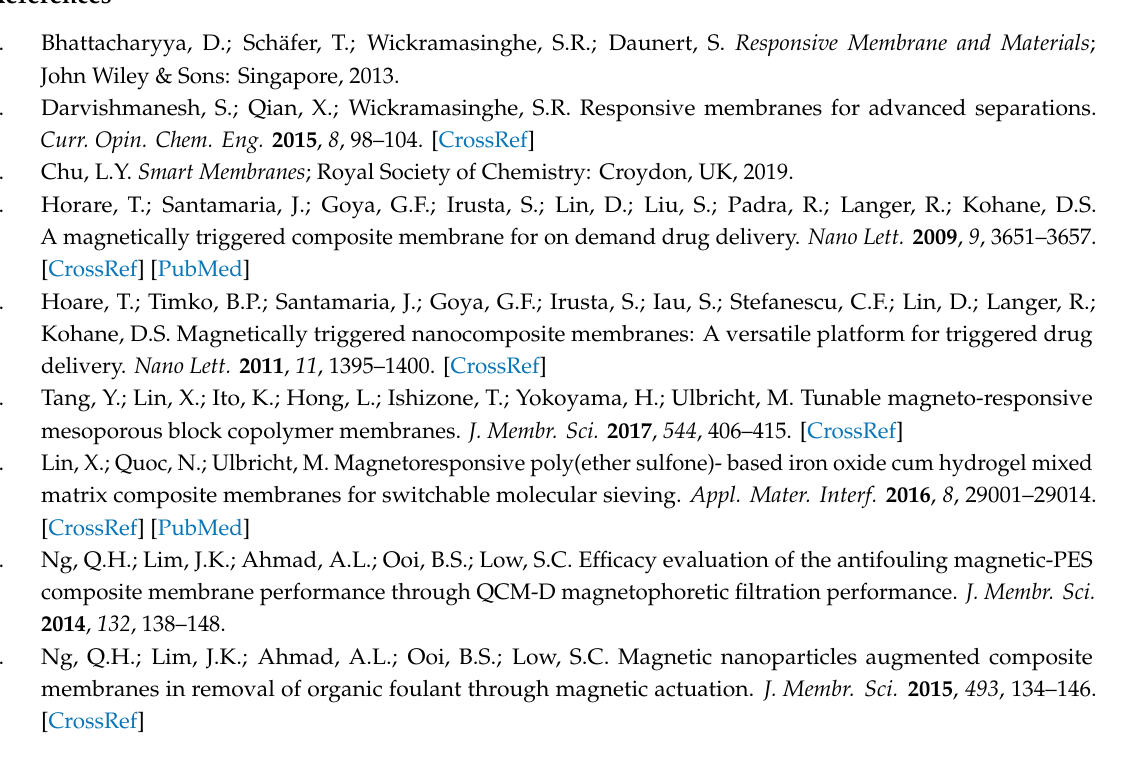
Figure S1: Schematic representation of the initiator immobilization protocol, Figure S2: Experimental set up for testing modified membranes, Figure S3: AFM images for 100 kD base RCUF